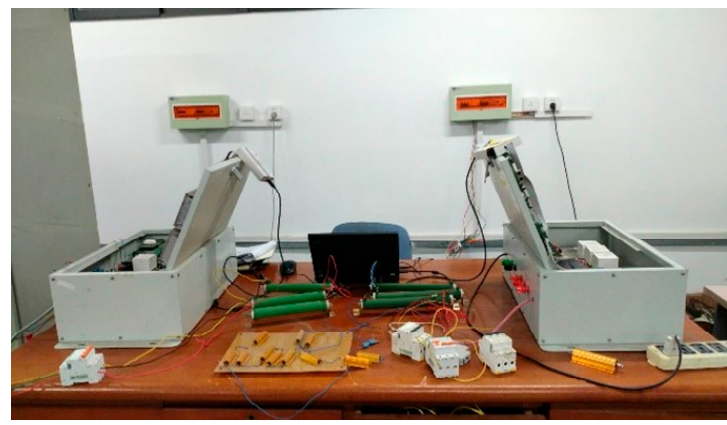
Figure 12. Experimental setup.